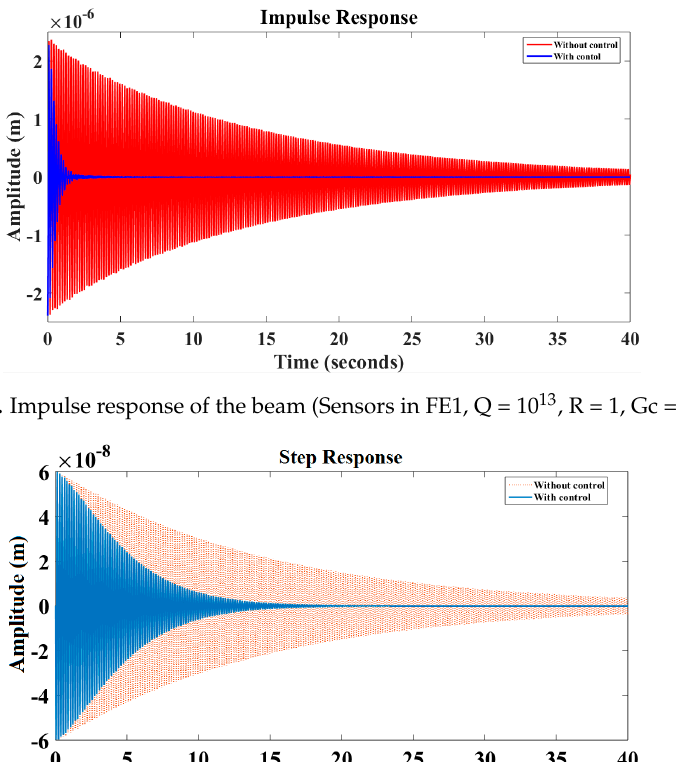
Figure 3. Impulse response of the beam (Sensors in FE1, Q = 10 11 , R = 1, Gc = 100).